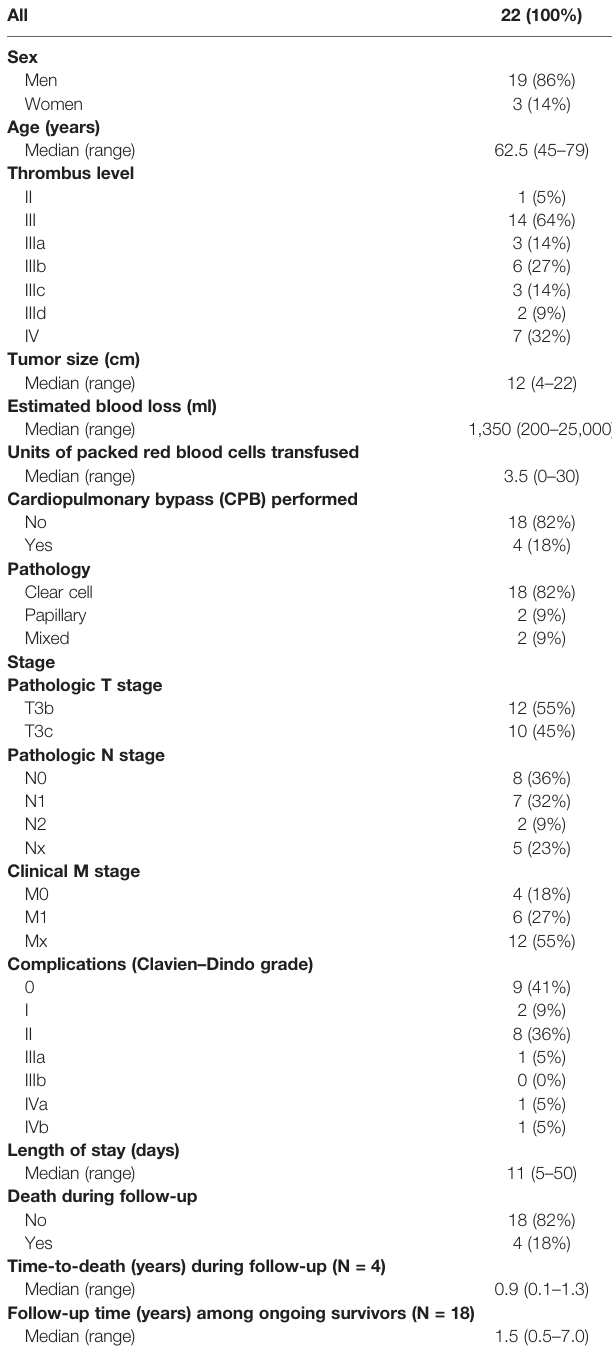
TABLE 1 | Patient demographics, tumor characteristics, and perioperative factors.